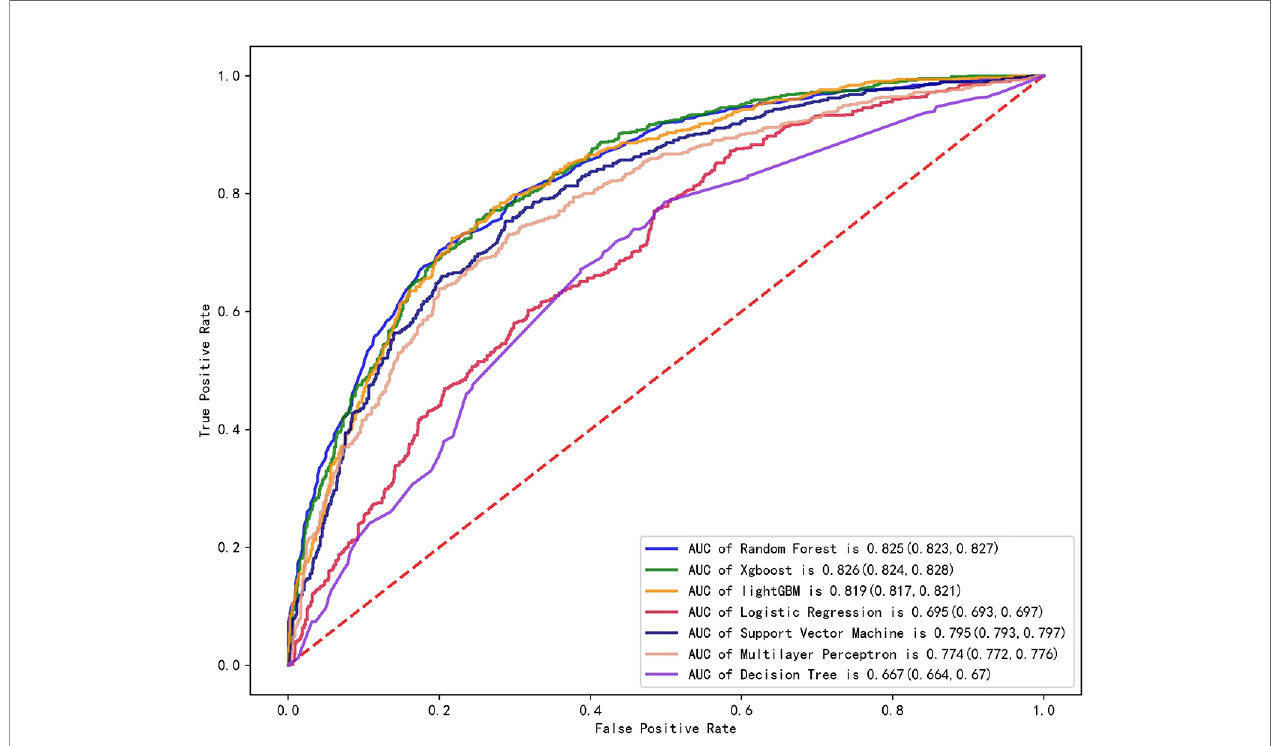
FIGURE 1 | Comparison of AUCs among seven machine learning models with ROC; RF got the greatest AUC for single model